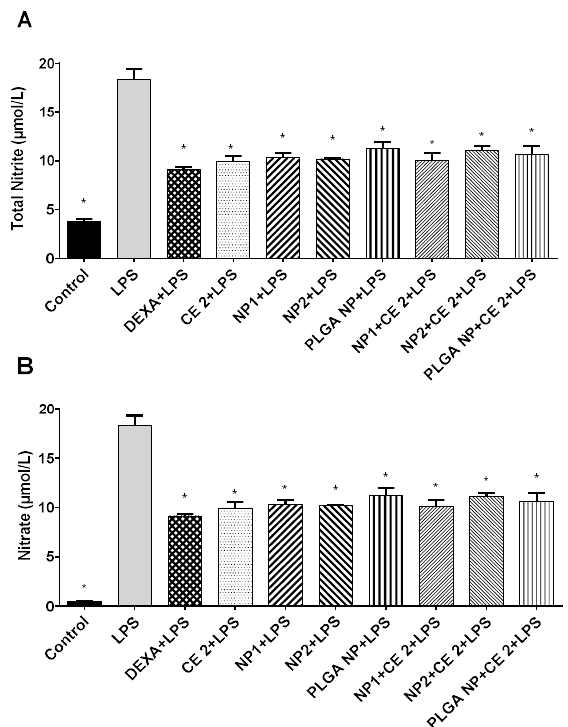
Figure 4. Nitrite ( A ) and nitrate production ( B ). HUVEC were treated with empty or CE-loaded NPs (NP1:QA-Ch-NP; NP2:QA-Ch-S-pro-NP; and PLGA NPs) with 2 µ g / mL GAE of CE (CE 2) or DEXA (5 µ g / mL) for 2 h and with LPS (10 µ g / mL) for 24 h. Data are expressed as mean ± SD of at least three independent experiments in triplicate. * p < 0.05 vs. LPS.